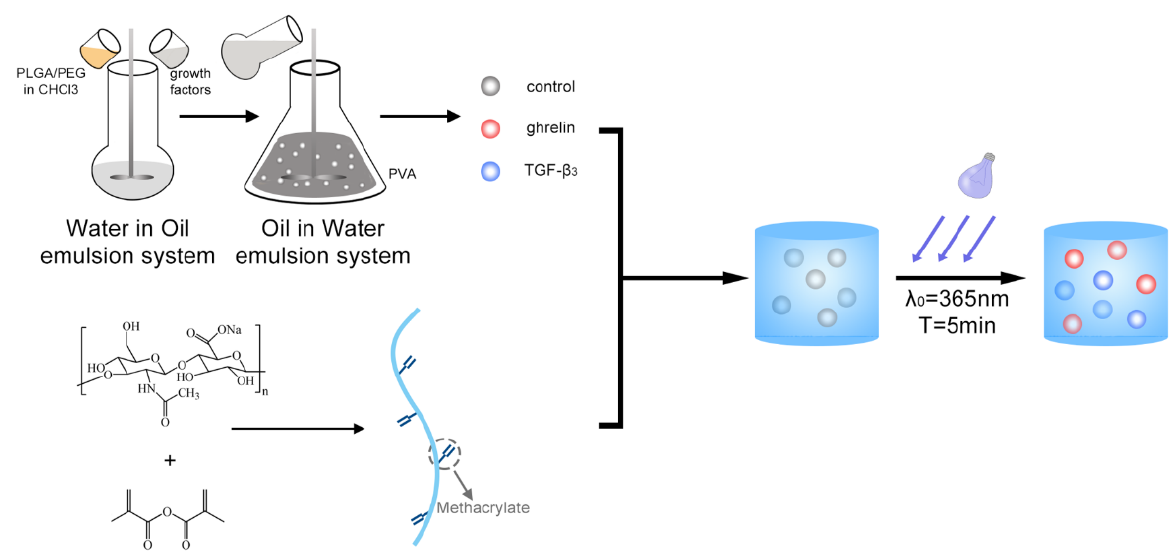
Figure 1. Schematic of the microsphere/hydrogel system.